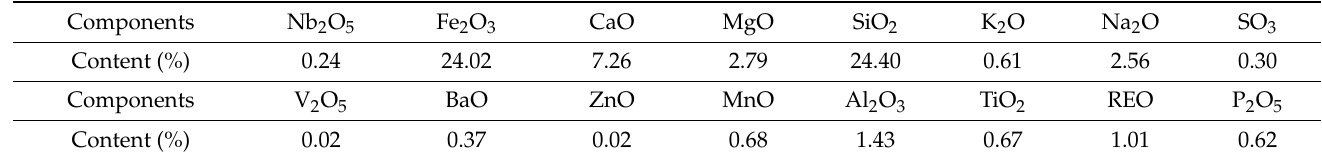
Table 2. XRF analysis of some important components of the niobium-bearing minerals in Baiyun Obo.